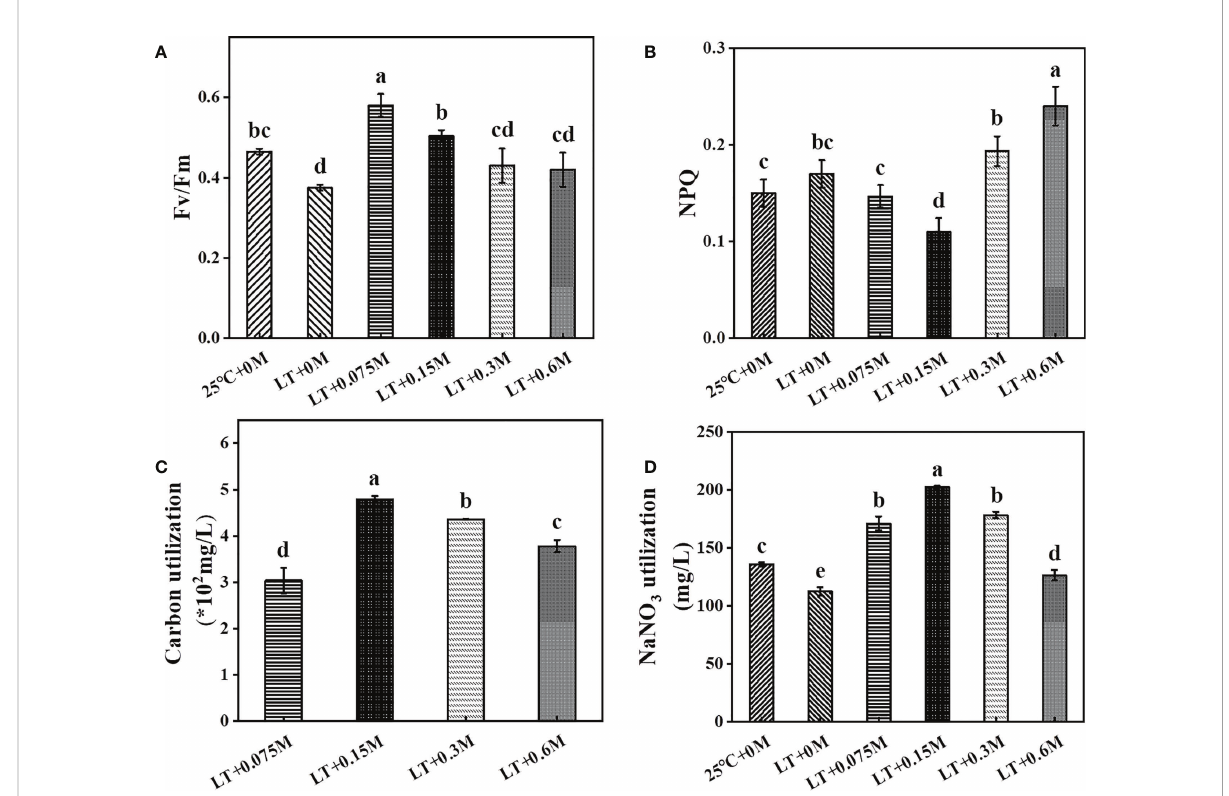
FIGURE 2 Effects of various combinations on HTBS photosynthetic performance [ (A) , Fv/Fm; (B) , NPQ] and nutrient removal rate [ (C) , carbon; (D) , nitrogen]. Data were mean ± SD of three